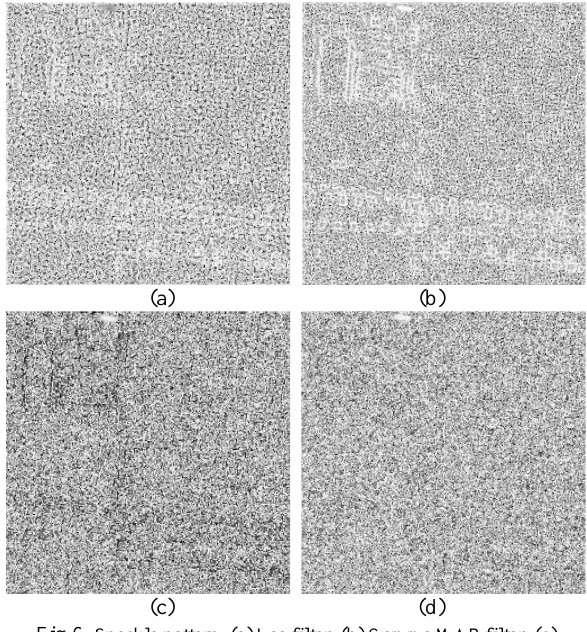
Fig 6. Speckle pattern: (a) Lee filter, (b) Gamma MAP filter, (c) improved non-local means, (d) our